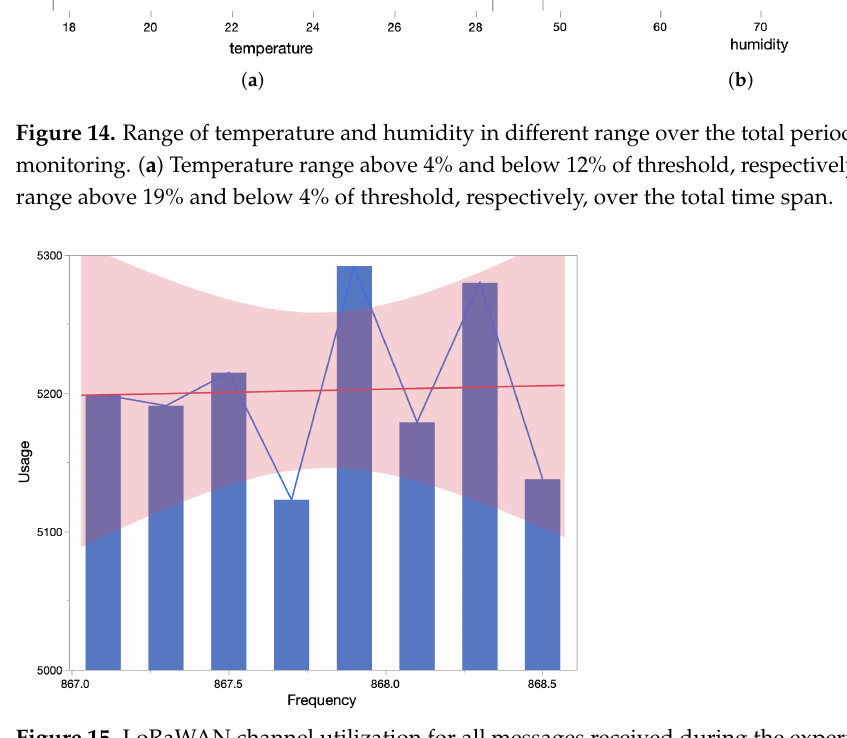
Figure 15. LoRaWAN channel utilization for all messages received during the